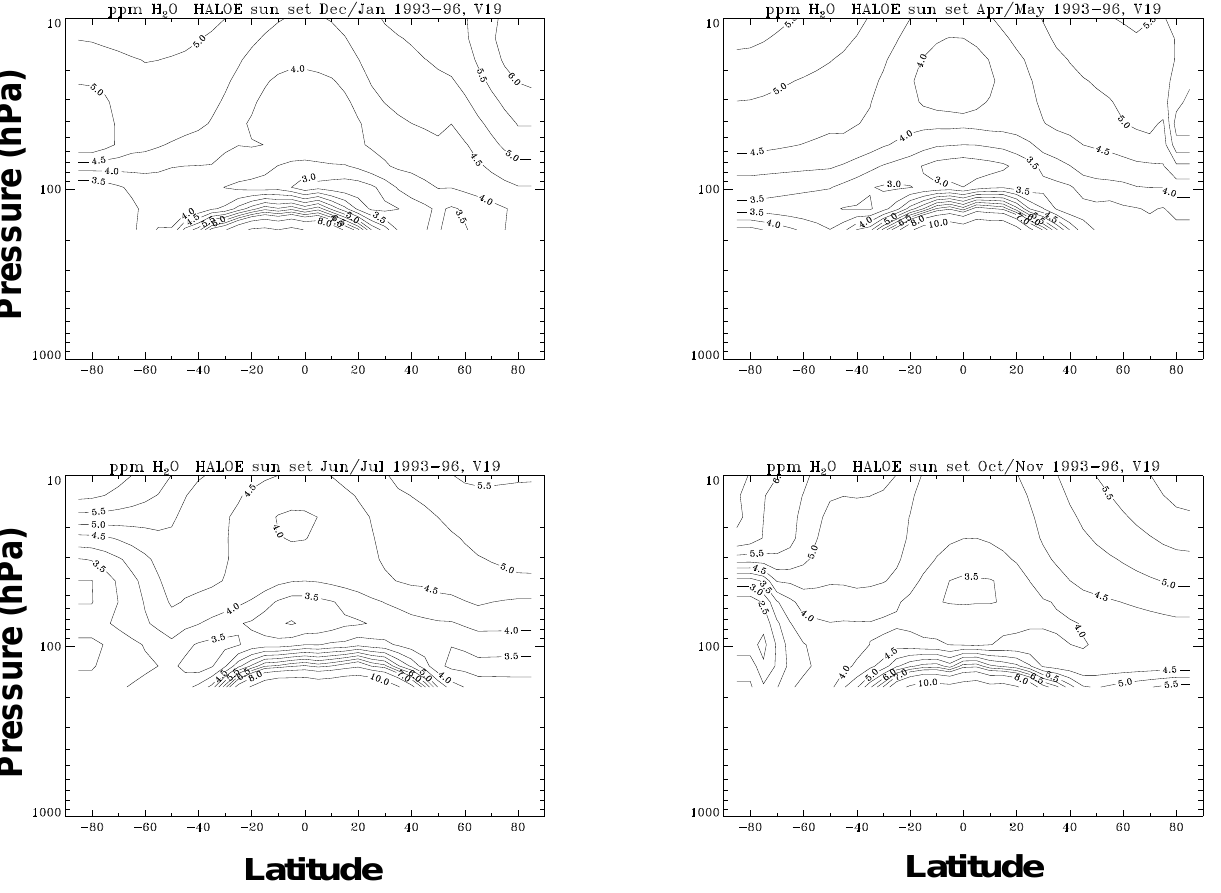
Fig. 14. Climatological monthly averages of the zonal mean observed water vapour mixing ratios (ppmv) for December/January, April/May, June/July, and October/November. HALOE satellite observations for the years 1993–1996 have been evaluated using data retrieval version 19. Data gaps in antarctic polar night have been filled by MLS observations (see text). The vertical axis is chosen as in Fig. 13 to allow an easy comparison. Below 174 hPa, no reliable satellite observations are